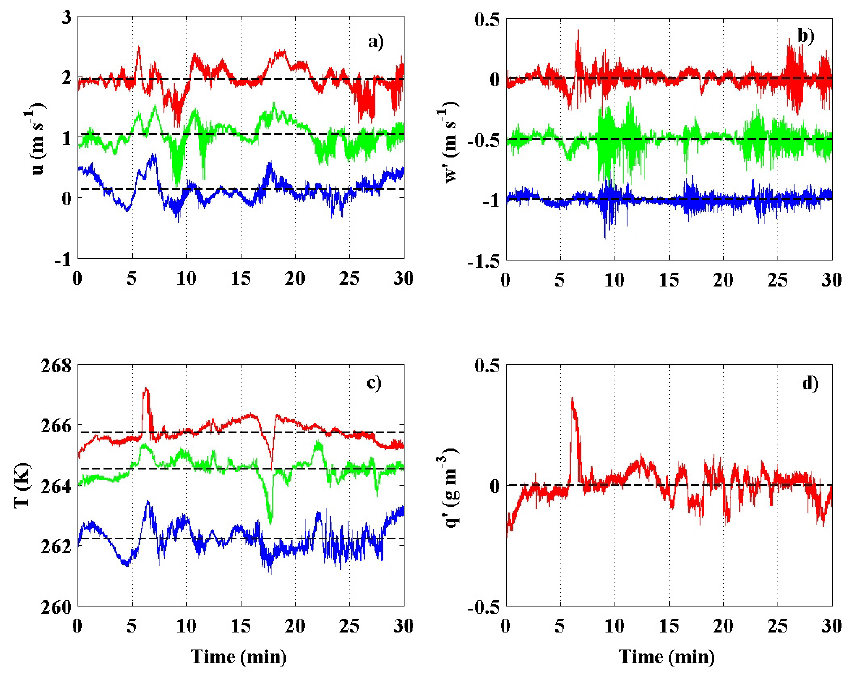
Figure 3. As per Figure 2 but for a selected case of a “dirty” wave (Wave 2). The